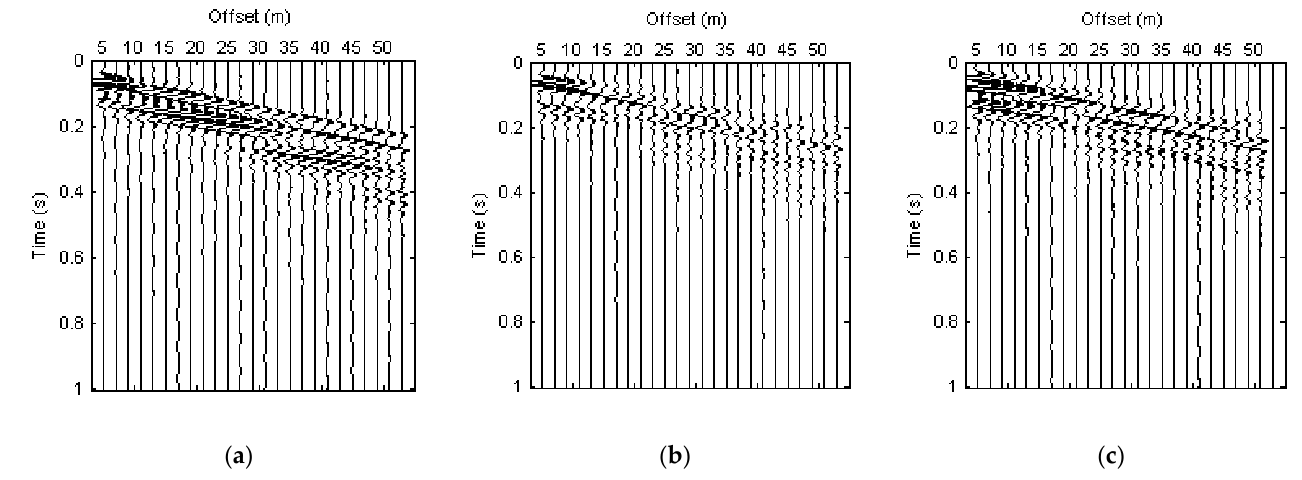
Figure 2. Synthetic data for Model 2. ( a ) X component; ( b ) Z component; ( c ) R y component.